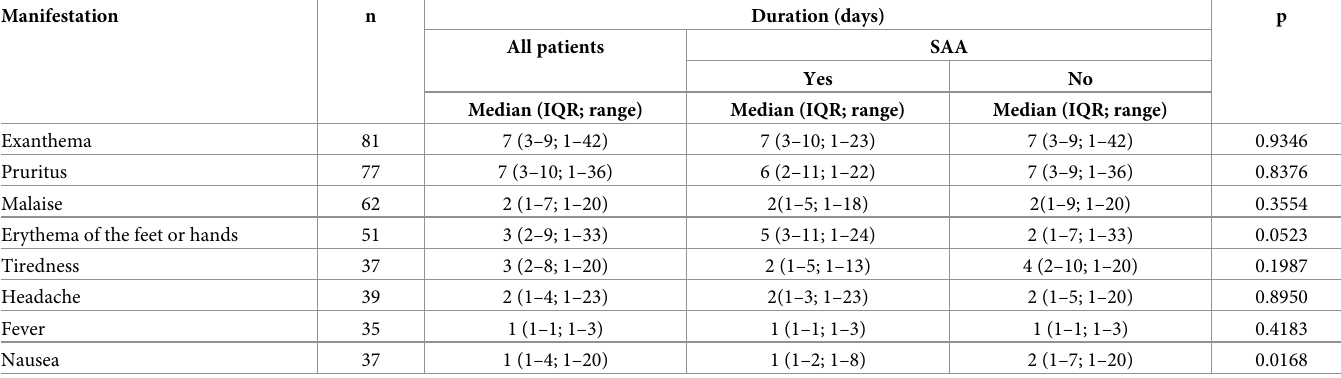
Table 3. Duration of systemic